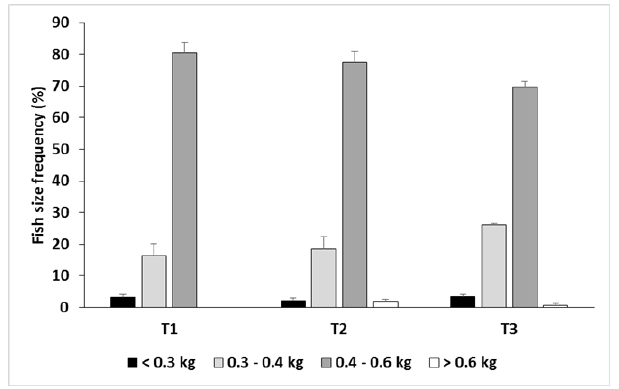
Figure 4. Fish size frequency distribution according to the commercial sizes managed by the seabream industry (mean ± standard error).